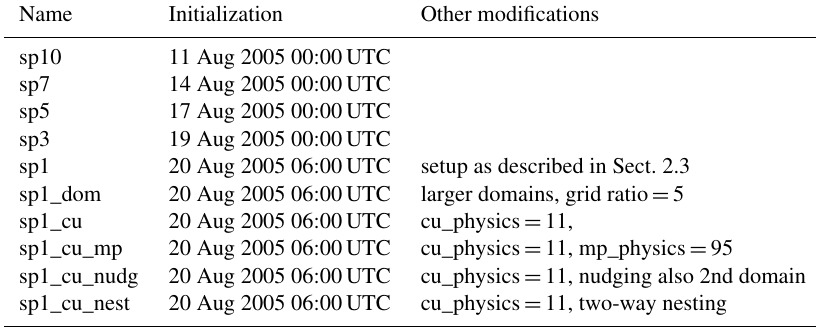
Table 1. Abbreviations and description of setup experiments ∗ .